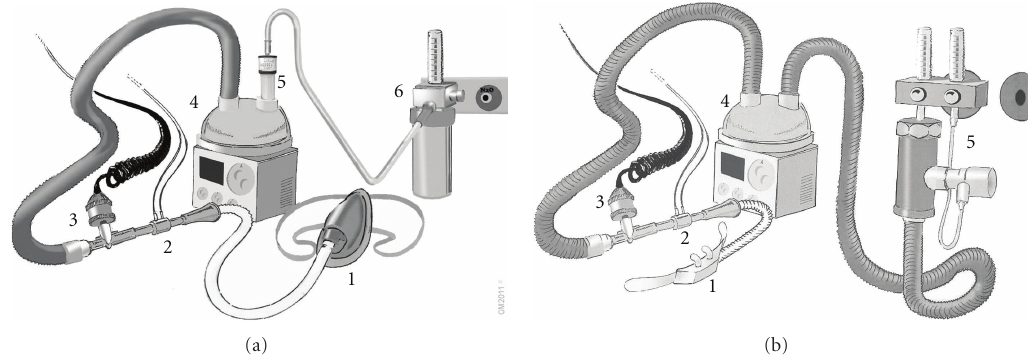
Figure 1: Diagram of the experimental setups. (a) Setup used for a flow rate of 40L/min. (1) Venturi mask. (2) Pneumotachograph. (3) Oxymeter. (4) Heater/humidifier. (5) Air entrainer with the Venturi e ff ect. (6) Wall mounted oxygen supply. (b) Setup used for delivering an airflow of 60 L/min. (1) High-flow nasal cannula. (2) Pneumotachograph. (3) Oxymeter. (4) Heater/humidifier. (5) Continuous high-flow generator with the Venturi e ff